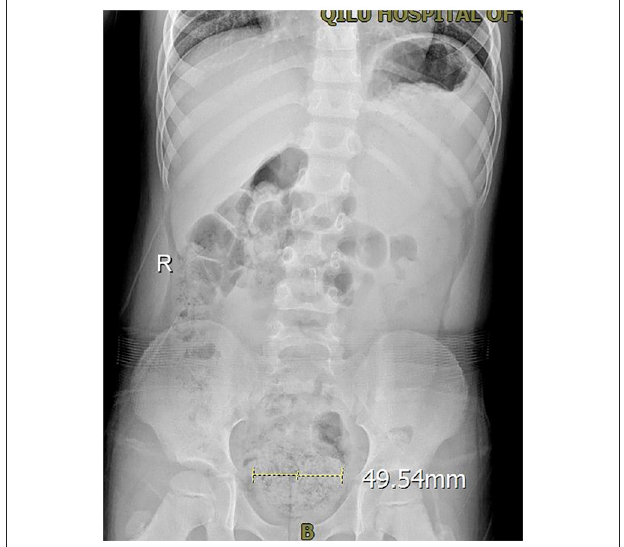
FIGURE 1 | The KUB of a PEDUF patient in an involuntary state showing that the rectum was dilated, and there were many intestinal